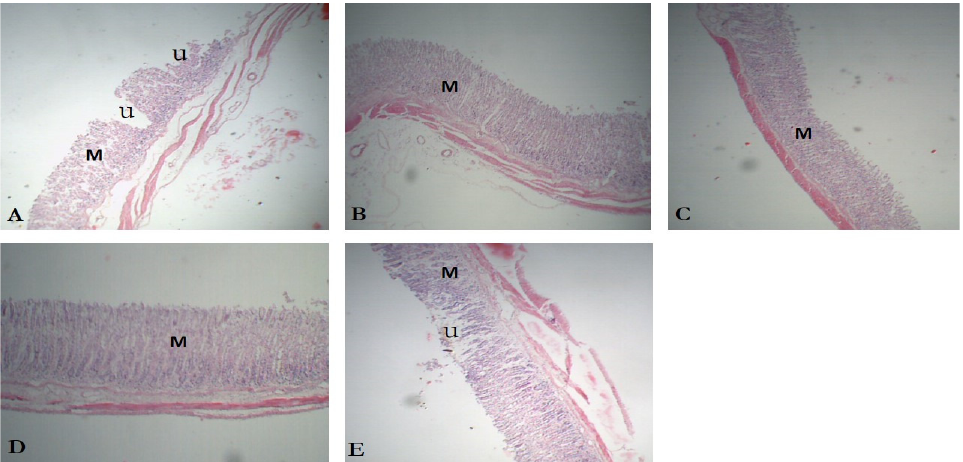
Figure 3. Histological section of the stomach of indomethacin-induced gastric ulcer in rats Legend: “U” = ulcer lesion, “M” = mucosa, A = Distilled water 5 ml/kg, B = Misoprostol 50 µg/kg, C =MFCS 12.5 mg/kg, D = MFCS 25 mg/kg, E = MFCS 50